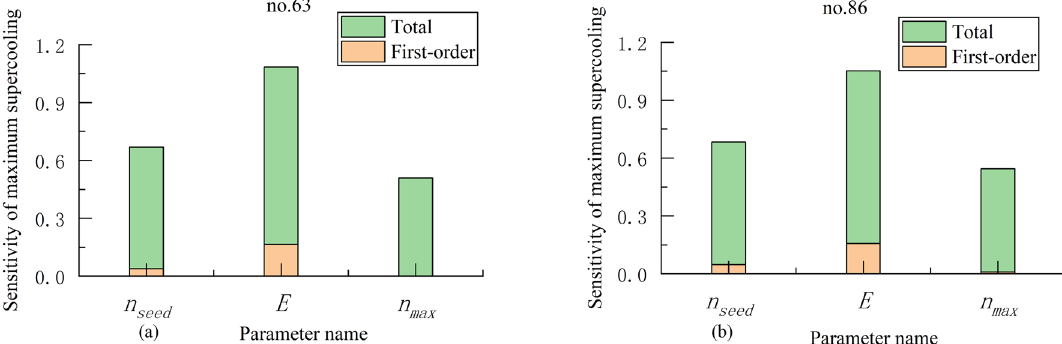
Figure 6. ( a ) The results of the Sobol analysis for three model parameters n seed , E , n max in the experiment no. 63. ( b ) The results of the Sobol analysis for three model parameters n seed , E , n max in the experiment no. 86.